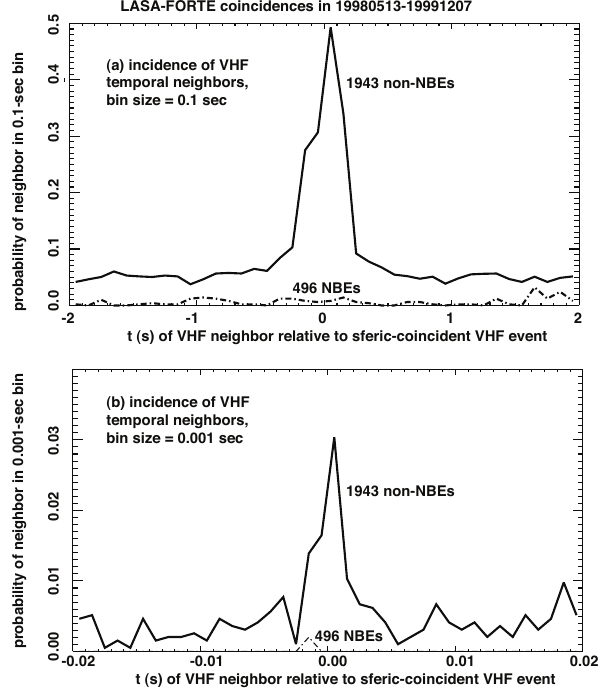
Fig. 12. Probability distribution of there being a FORTE VHF neighbor in bins of delay with respect to those FORTE VHF key events that are tight coincidences with LASA sferics. Solid curve: Non-NBE key events; dashed curve: NBE key events. Bin width is (a) 0.1s, and (b)